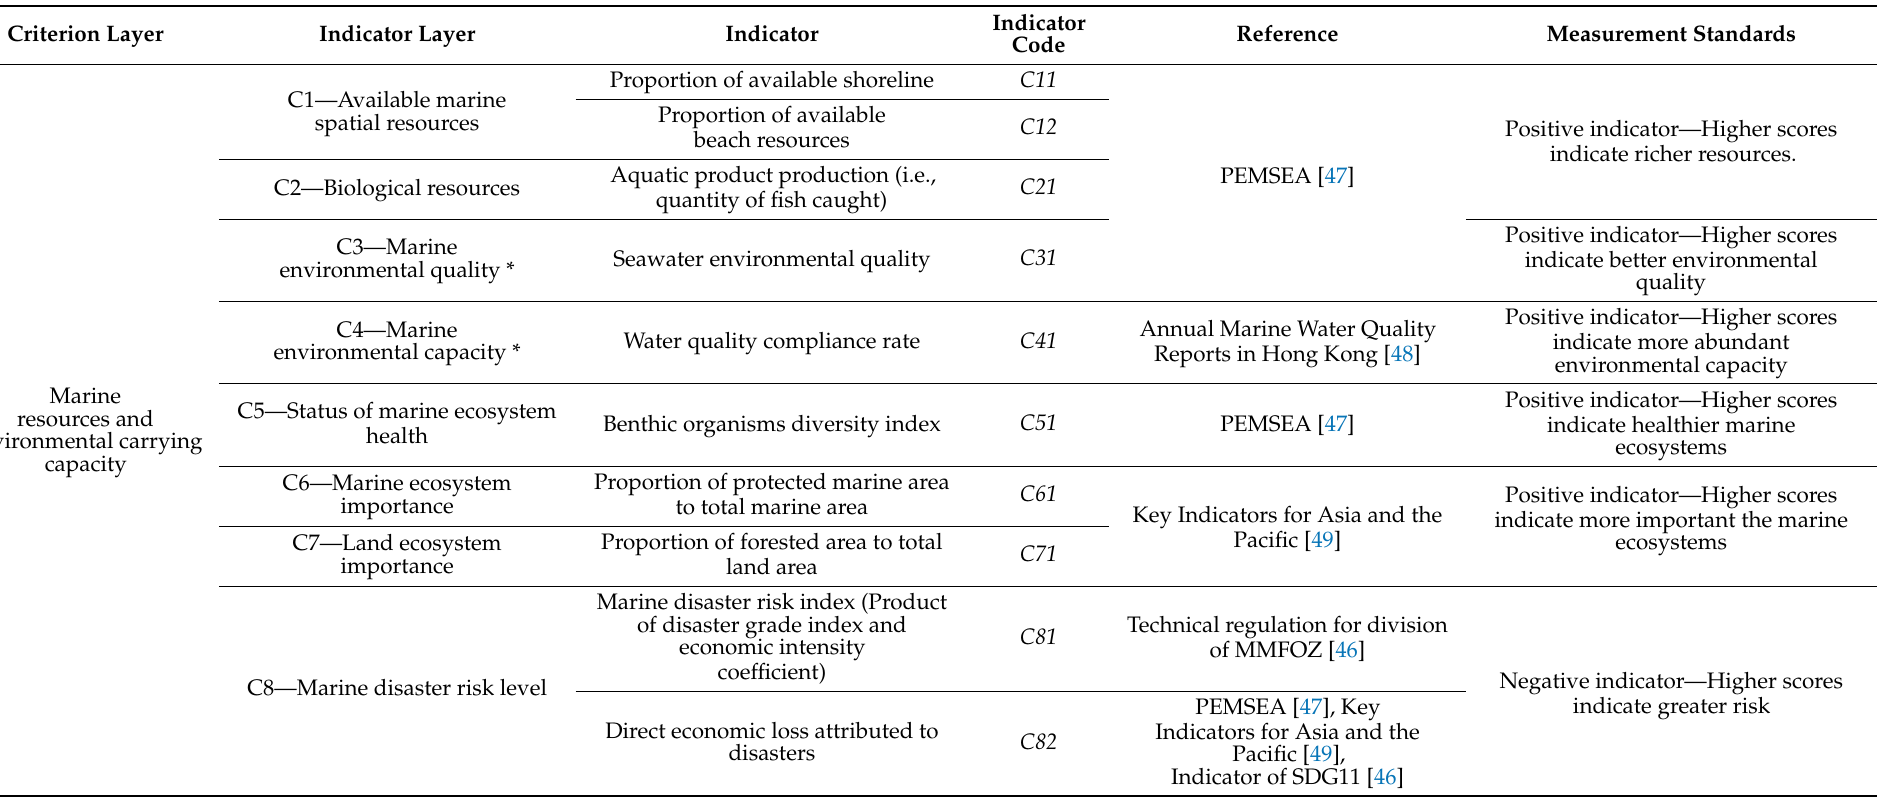
Table 2. Indicator evaluation system for